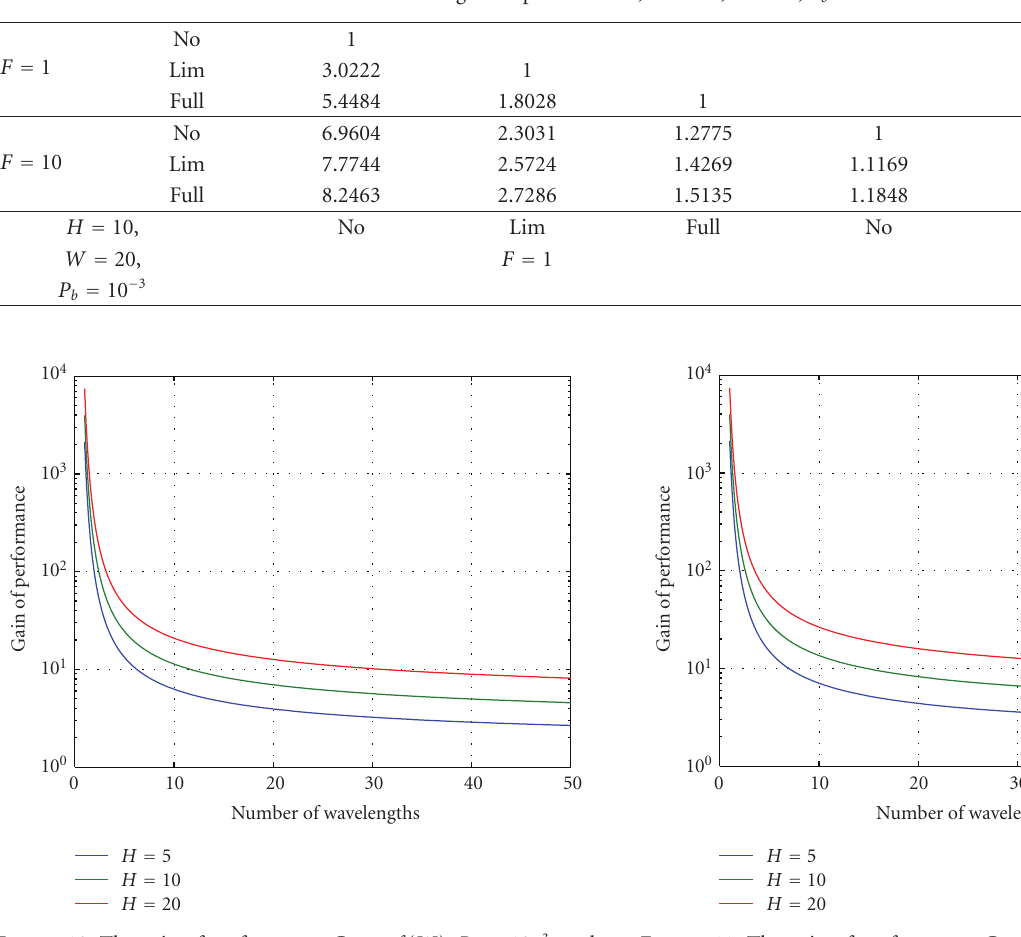
Figure 11: The gain of performance G = f ( W ), P b = 10 − 3 , and F = 10 Full/ F = 1 no.